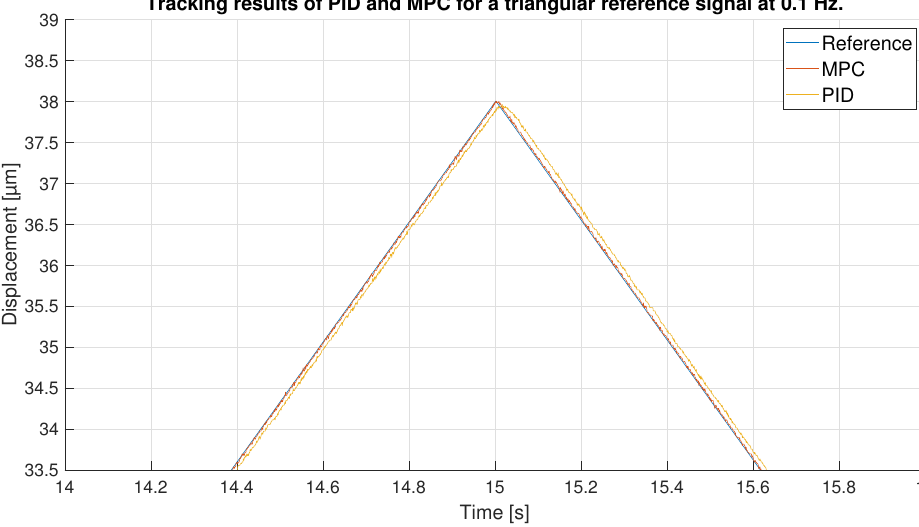
Figure 12. Zoom of tracking results in 0.1 Hz triangular signal